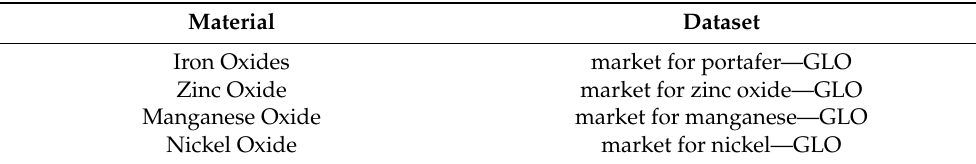
Table 1. EcoInvent dataset selection.